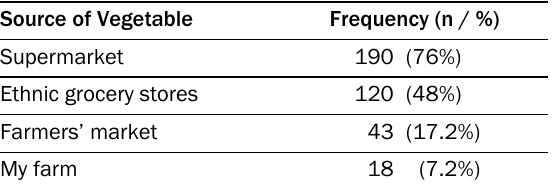
Table 3. Source of Vegetables Consumed